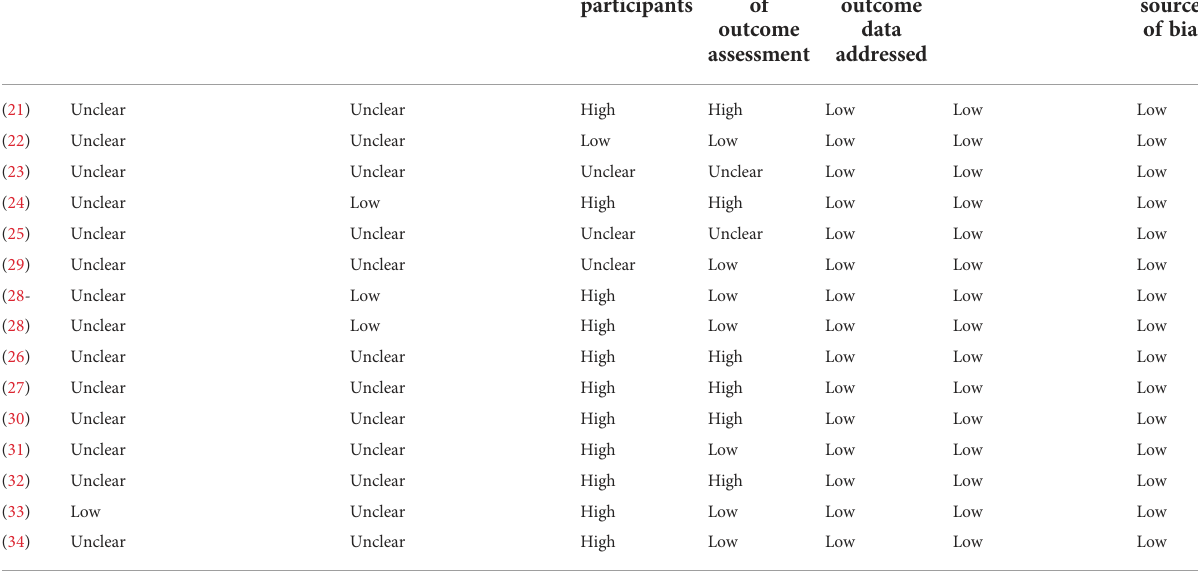
TABLE 2 Details of study quality evaluation via the Cochrane ’ s Risk of Bias Tool. Study Randomsequencegeneration Allocationconcealment Blinding